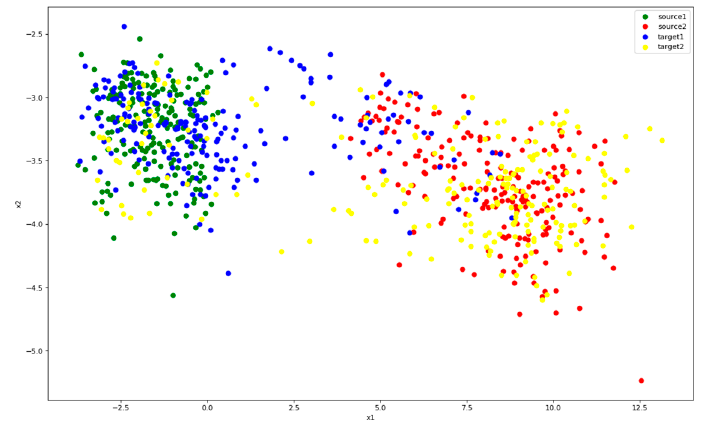
Figure 13. Distribution of features after MMD. Color green represents class 1 of source and red represents class 2. Blue is the class 1 of target and yellow the class 2.